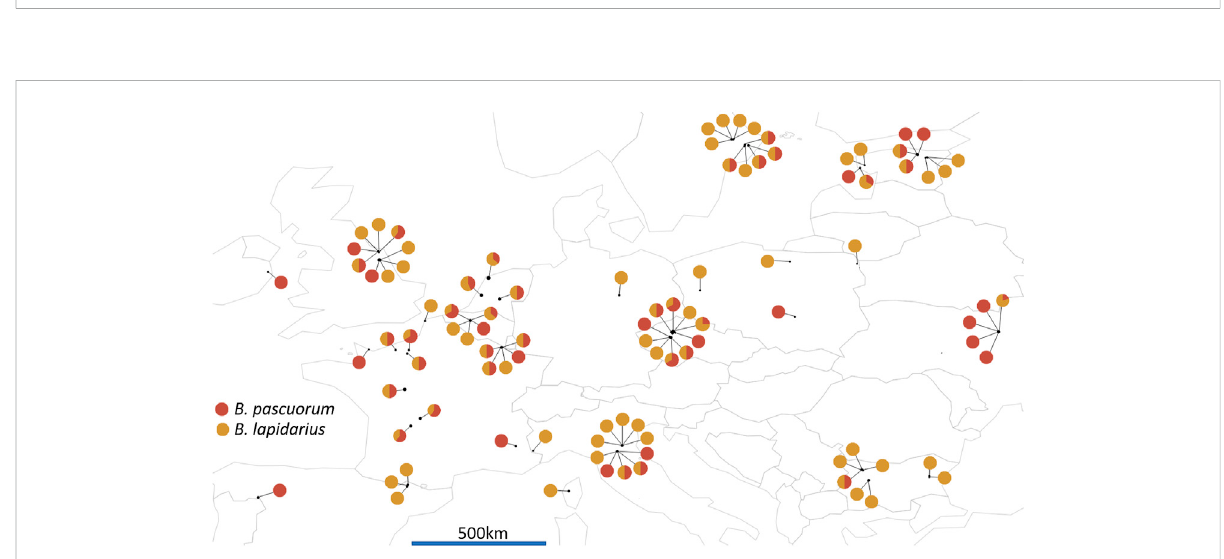
Concentration was measured using a TECAN platform and Quant-it PicoGreen dsDNA Assay Kit (Thermo Fisher Scienti fi c, Belgium) before normalisation to 50 µl of 20 ng/ μ l for library preparation.